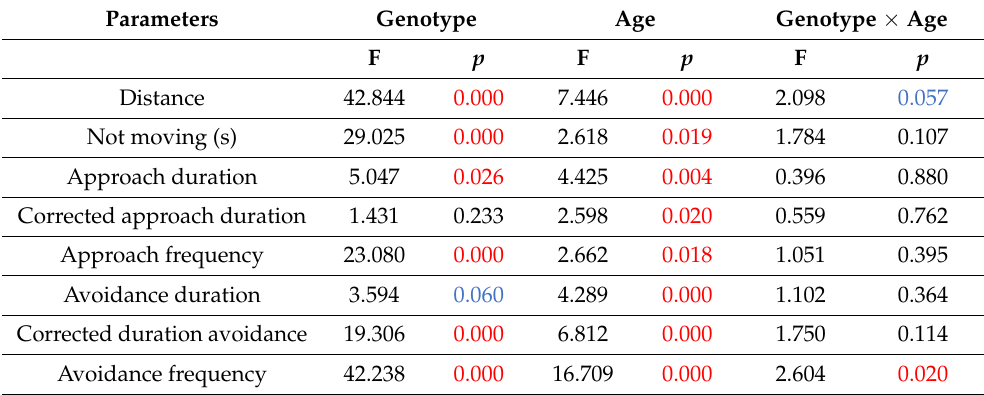
Table 1. Statistical data (results of factorial ANOVA) of fox odor avoidance behaviour (Experiment 1). The corresponding data are presented on Figure 1. Parameters were analyzed by EthoVision software. Male control and 3xTg-AD mice were compared in 2–18-month age range. Degree of freedom was 1132. Significant main effects are highlighted in red, while blue colour represents marginally significant difference.